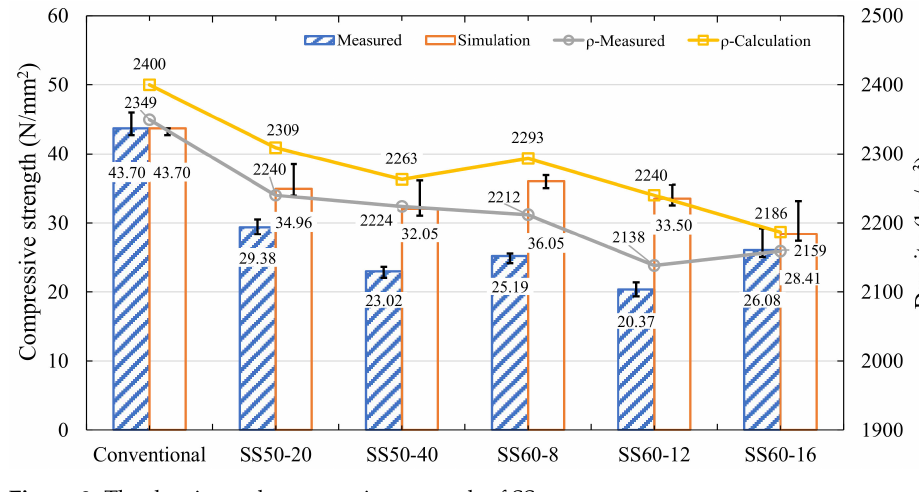
Figure 3. The density and compressive strength of SS concrete.